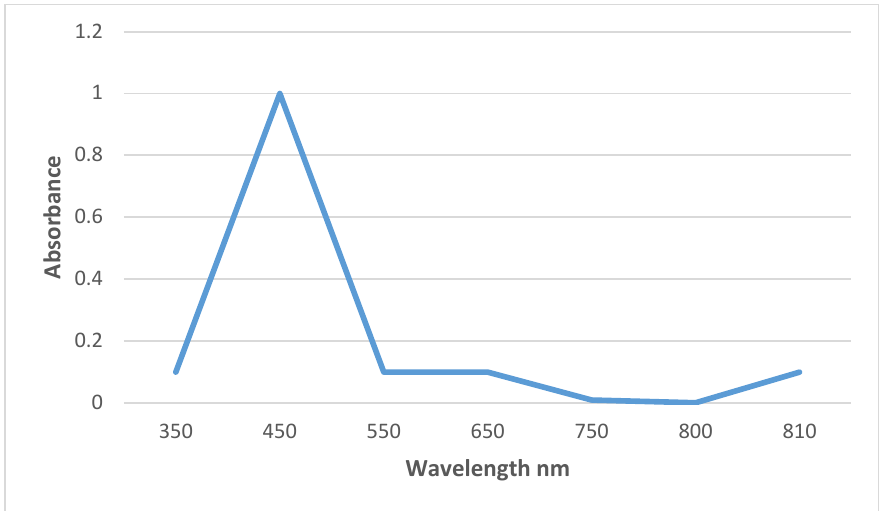
Figure 5. UV/Vis spectrum. The surface plasmon resonance peak of the Bs-AgNP solution observed at 450 nm confirmed the synthesis of small, polydisperse silver nanoparticles.